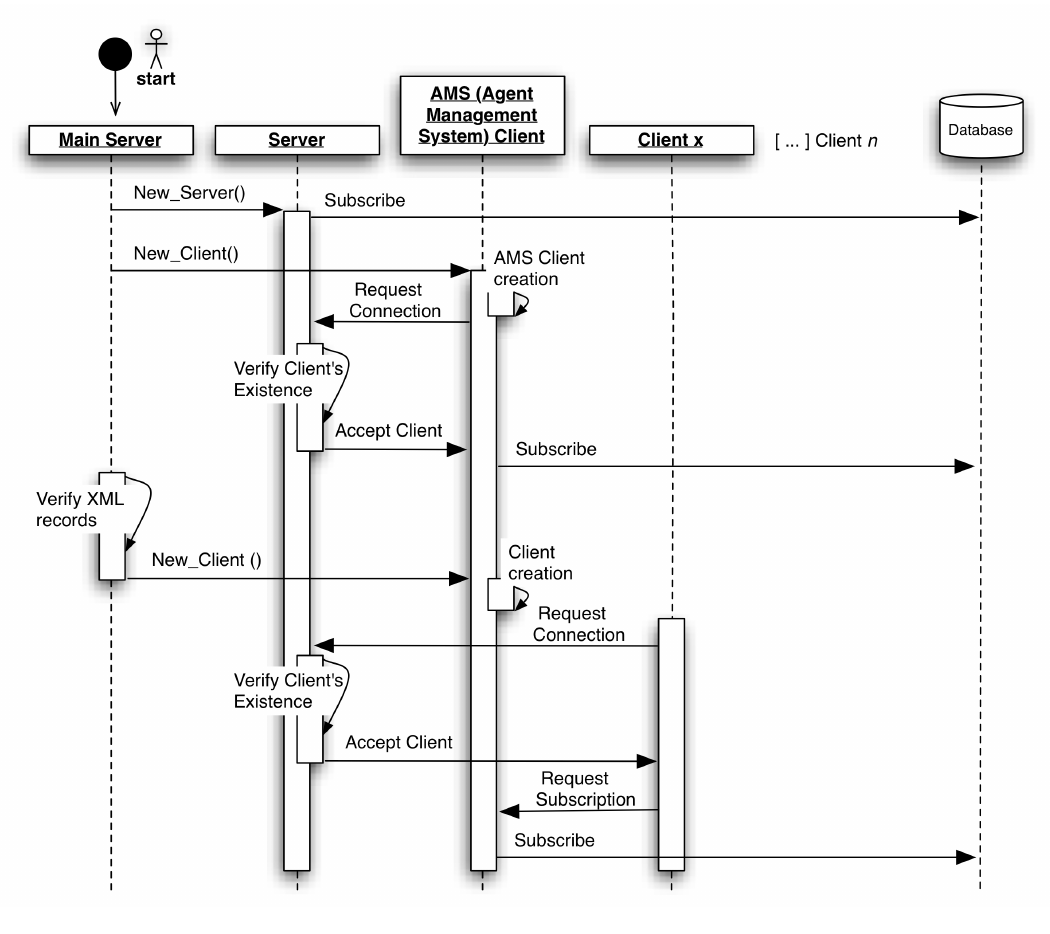
Automatic boot process of the module for controlling the agent community of Agency for Integration, Diffusion and Archive of Medical Information